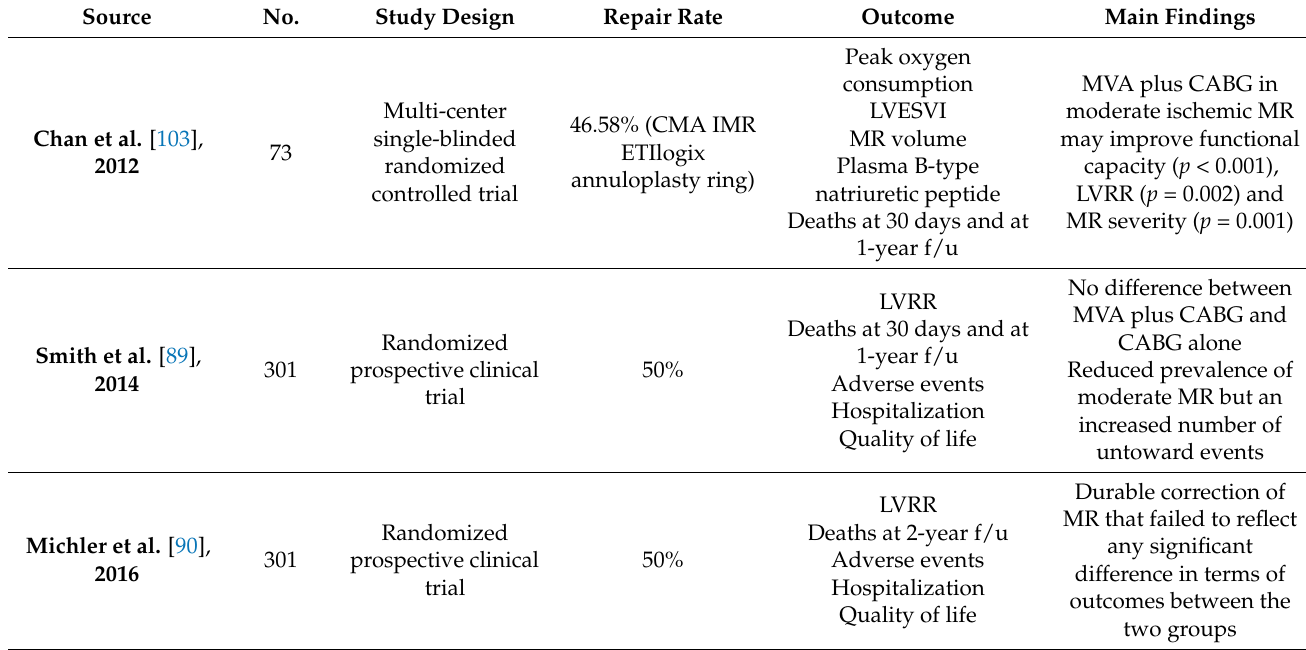
Table 5. Findings from major studies comparing clinical outcomes of adjuvant MVA in CABG patients versus standalone CABG in the management of moderate